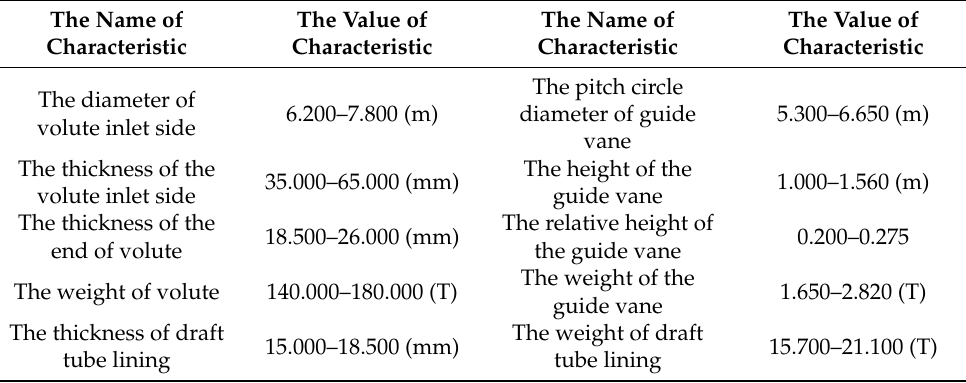
Table 3. The Design Requirement Parameters of Partial Flow Path